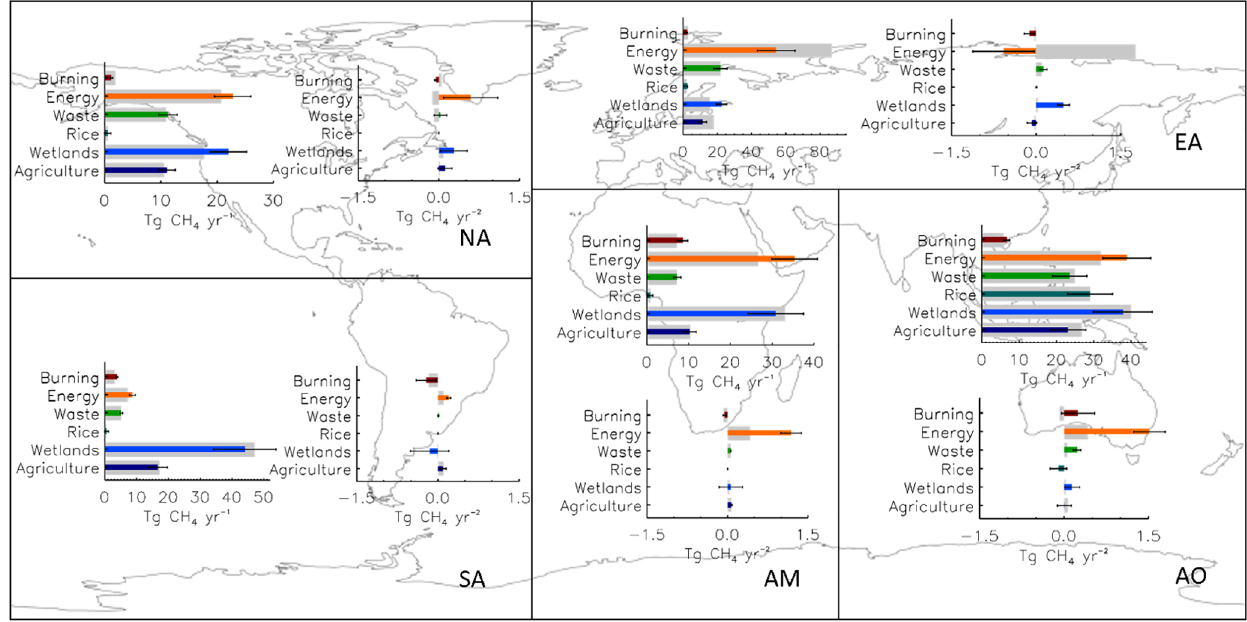
Figure 7. Map showing regional annual mean CH 4 emissions (TgCH 4 yr − 1 ) and yearly change in emissions (TgCH 4 yr − 2 ) calculated as a linear regression between 2003 and 2015 for INV-FULL (thin coloured bars) and prior (thick grey bars) estimates. Error bars represent 1 standard deviation of the mean posterior emissions and posterior regression errors. Note that the black borders indicate the five regions used for the flux partitioning.